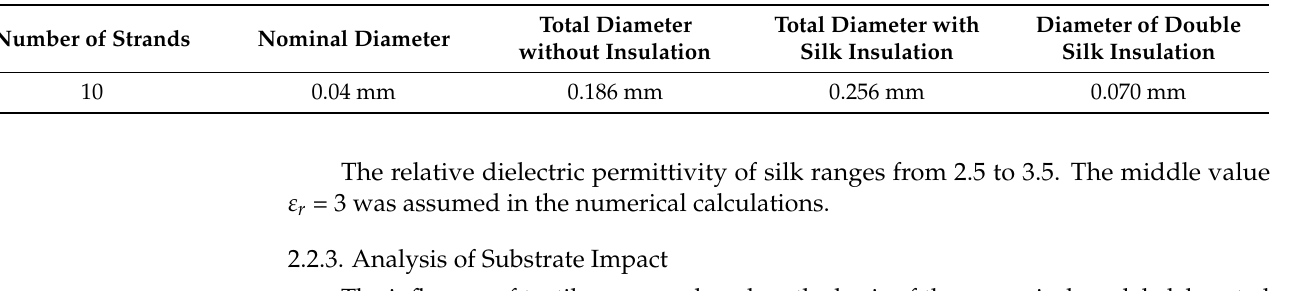
Table 11. Parameters of PACKLitzWire 10 × 0.04 (2 × 52) litz wire entered into the numerical model.